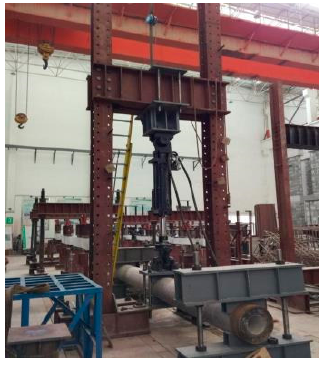
Figure 2. The schematic diagram of the loading device.